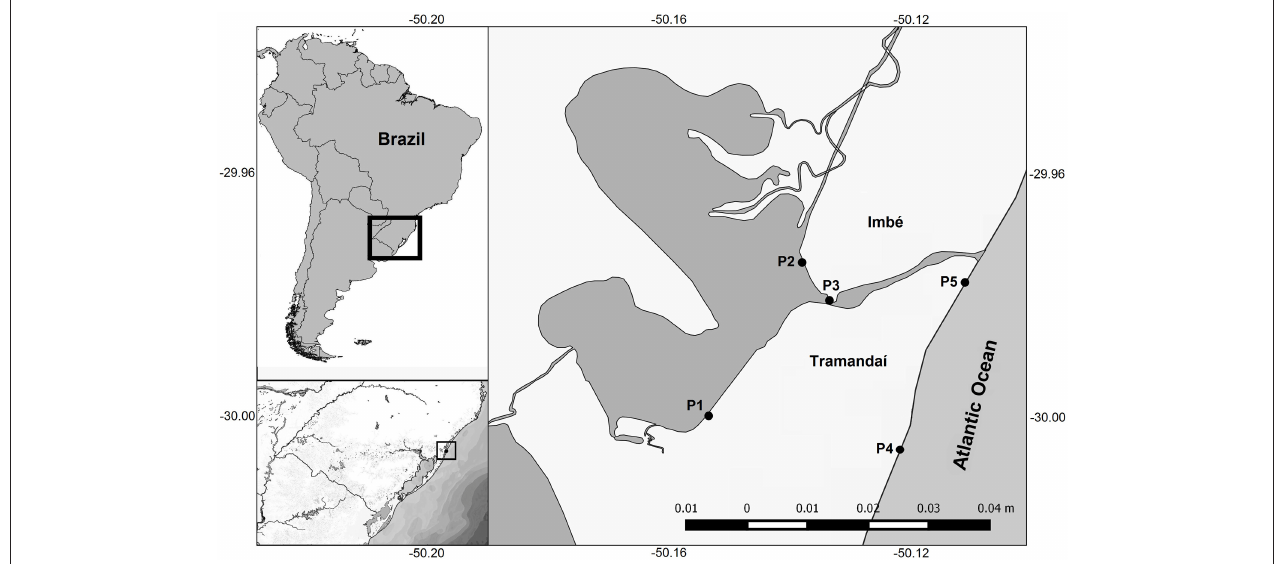
FIGURE 1 | South America, Brazil, Rio Grande do Sul State, and study area with the location of collection points in the Tramandaí River estuary (TRE; P1, P2, and P3) and adjacent coast (AC; P4 and